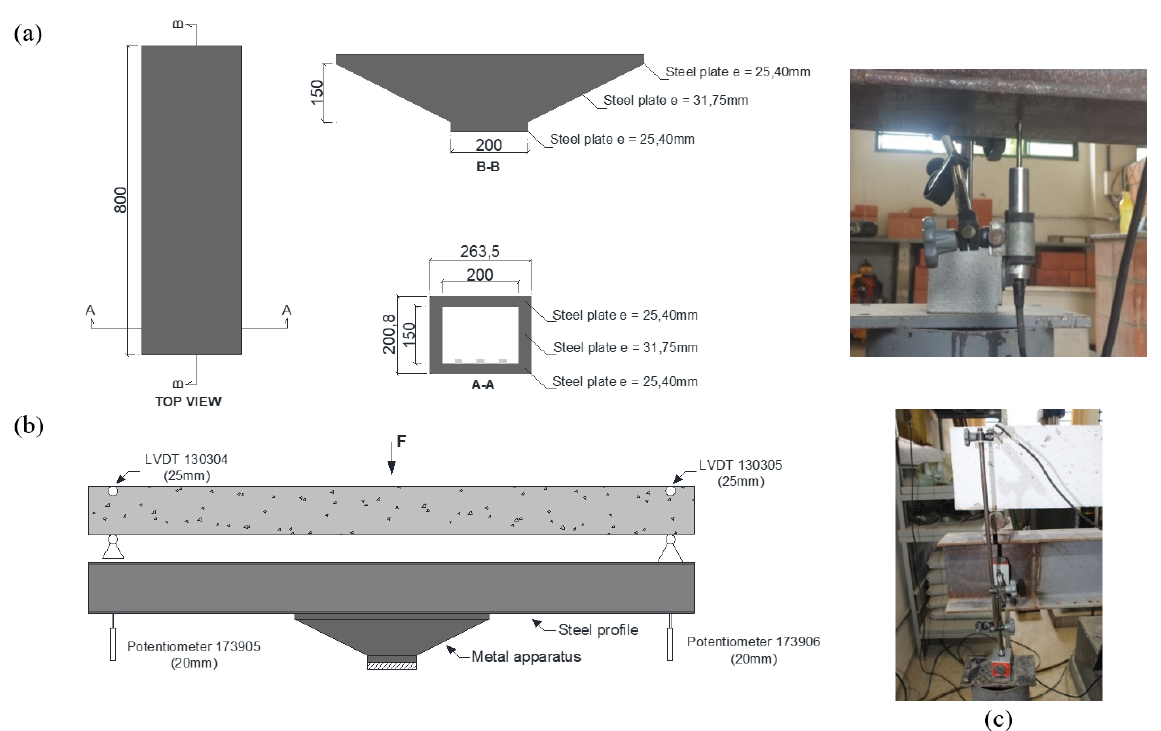
Figure 9. (a-b) Steel apparatus and (c) details of the positioning of the LVDTs and potentiometers used to measure the displacement of the metal beam and rotation of the supports (units in Figure 9a: